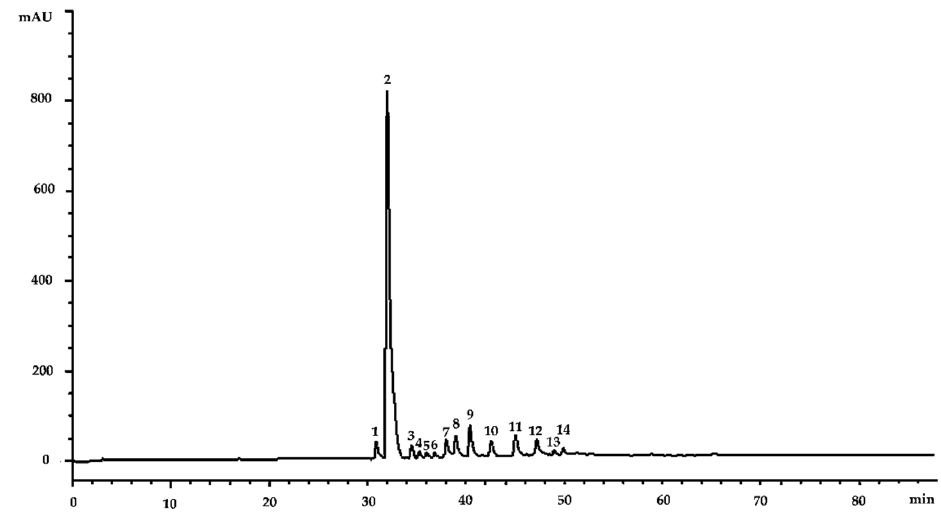
Figure 1. Representative LC-DAD chromatogram of A. glutinosa bark extract (AGE) acquired at 292 nm, a wavelength at which it is possible to observe all the identified compounds. Peak numbers, which follow the elution order, correspond to compounds listed in Table 1.